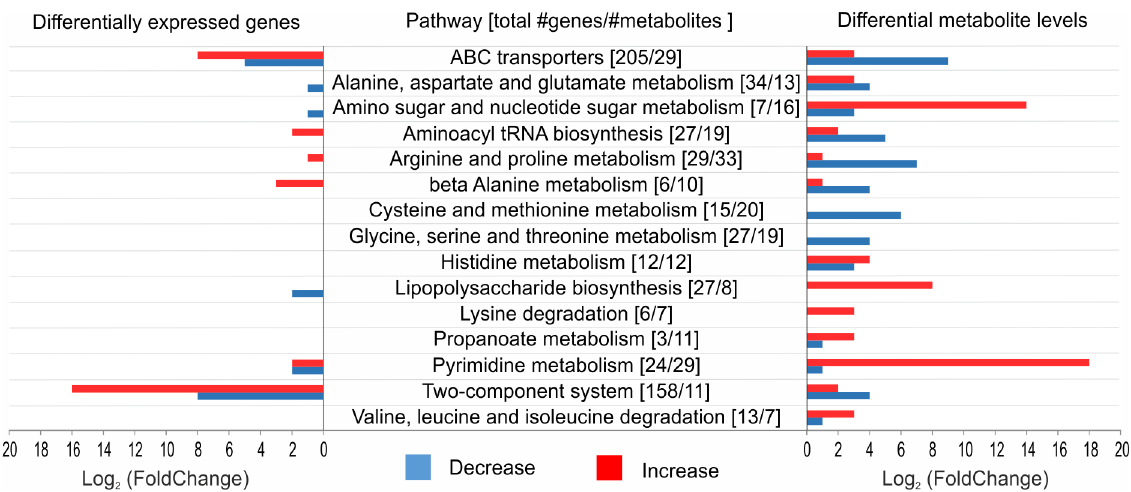
Fig 6. Comparison of significant changes in transcriptomics and metabolomics data from PAK_P3 infected cells reveals no direct correlation. On the left, the number of genes with a significant differential expression ( │ Log 2 (fold change) │ > 1.3, p- value < 0.05) is shown. On the right, an overview of the number of metabolites with significantly changed levels ( │ Log 2 (fold change) │ > 0.5, p-value < 0.05) is shown. The middle column entails all studied metabolic pathways and indicated between brackets are, respectively, the total number of genes and metabolites involved in this pathway. Red = increase in transcript/ metabolite level, Blue = a decrease in transcript/metabolite level.